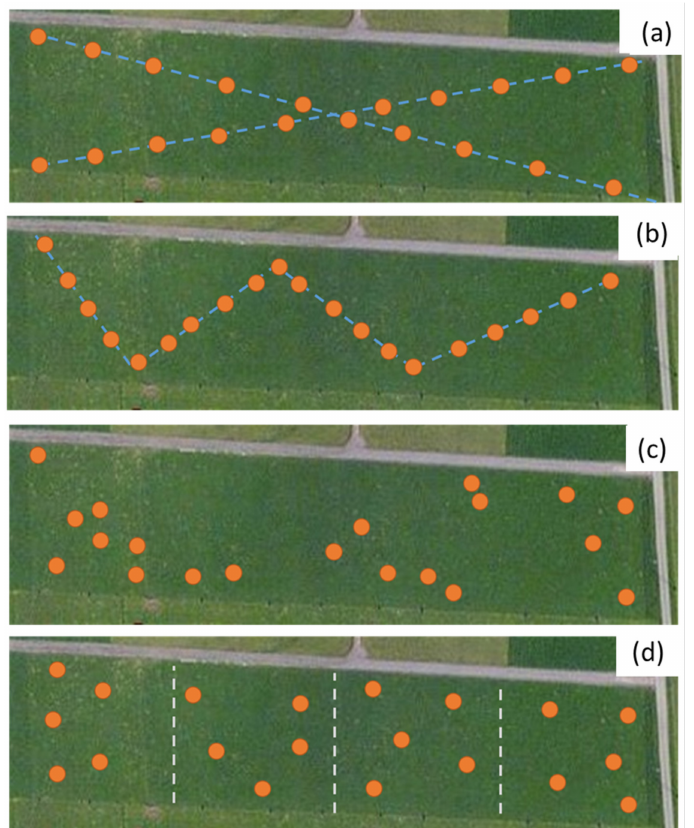
Figure 2. Illustration of ( a ) ‘X’ transect; ( b ) ‘lazy W’; ( c ) simple random; and ( d ) random stratified sampling pasture measurement protocols on 1 ha grazed pasture, with orange circles indicating measurement locations ( n = 20) and blue dashed line outlining the measurement route for ( a ) and ( b